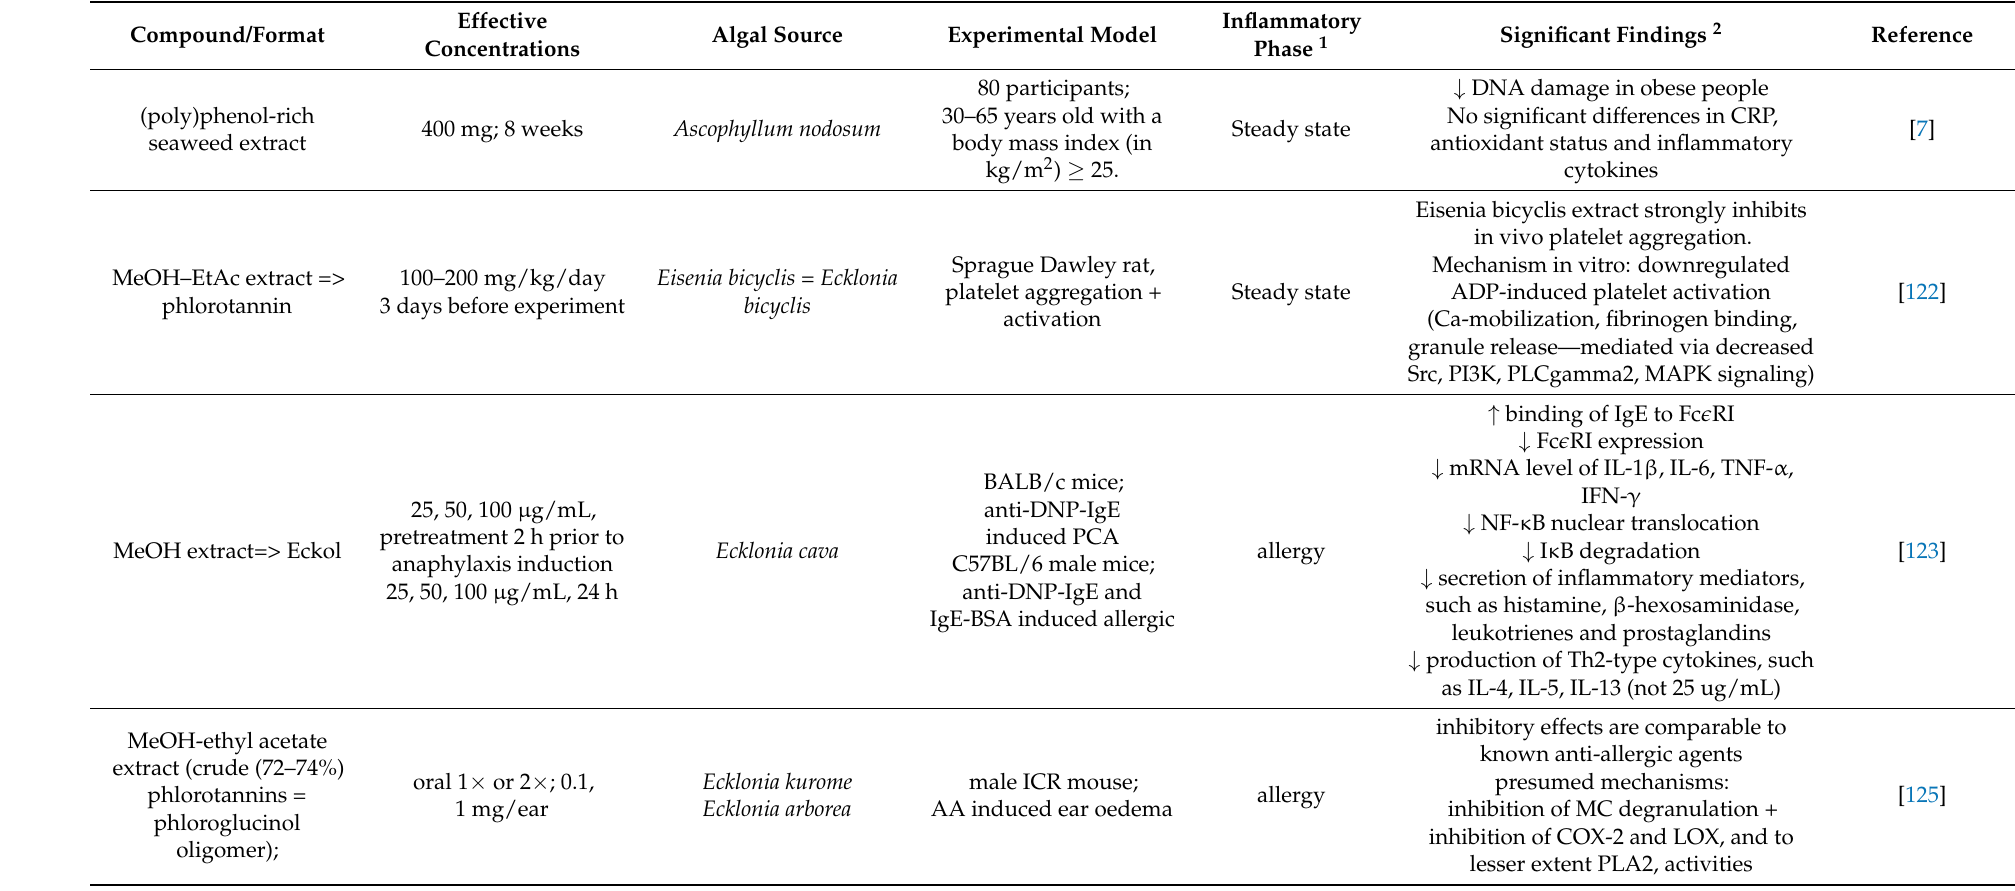
Table A4. Effects of oral supplementation of brown seaweed derived phenolic compounds on inflammation-related